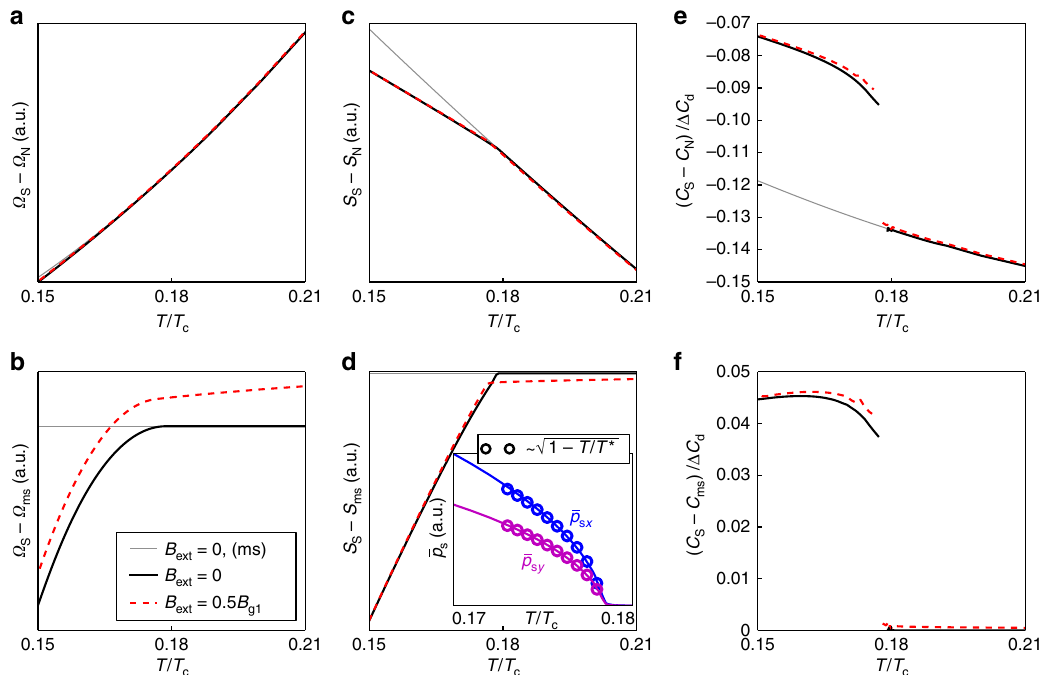
Fig. 6 Thermodynamics and phase transition. a , b free energy, c , d entropy, and e , f speci fi c heat capacity, versus temperature. The lines correspond to a system with purely real order parameter without edge currents (gray fi ne line), a system with spontaneous edge currents in zero magnetic fi eld (black solid line), and in a fi nite external fi eld B = 0.5 B g1 (red dashed line). In the lower panels b , d , and f , the quantities have been subtracted by the corresponding values of the system with a purely real order parameter, the metastable (ms) state. The heat capacity is normalized by the heat capacity jump at the normal-superconducting phase transition for a bulk d -wave system, Δ C d in Eq. (7). The inset in ( d ) shows the temperature dependence of the super fl uid momentum near T * , averaged over a few source – sink unit cells at one edge. It follows the expected temperature dependence for the order parameter at a